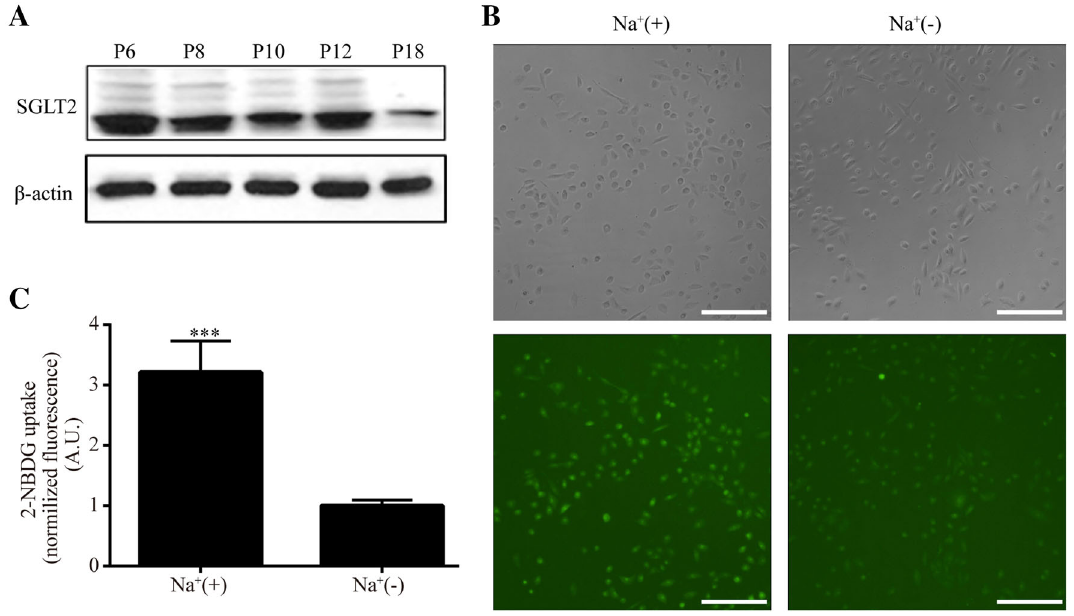
Fig. 1 Endogenous SGLT2 of HK-2 cells mediates glucose uptake. a Western blot of SGLT2 expressions in serial passages of HK-2 cells. b HK-2 cells were incubated in Na ? (left) or Na ? -free (right) buffer for 30 min with 200 l M 2-NBDG. Both the bright field images and the fluorescent images were taken at 10 9 magni- fication of objective. Na ? ( ? ), sodium buffer; Na ? ( - ), sodium free